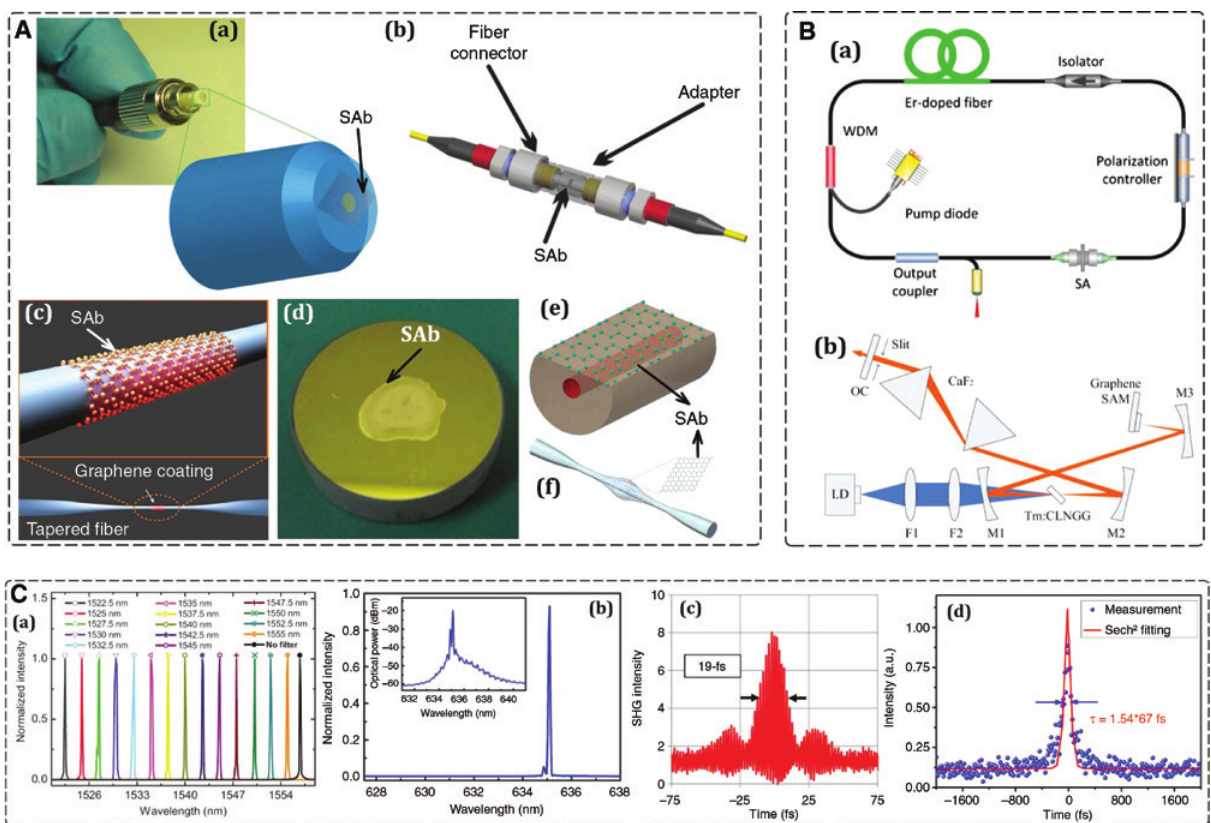
Figure 13: Ultrafast laser spectroscopy of 2DLMs. (A) Schematic illustration of 2DLMs-based SAbs. (a) Graphene film coated on fiber pigtail [111], (b) sandwiching graphene-PVA between